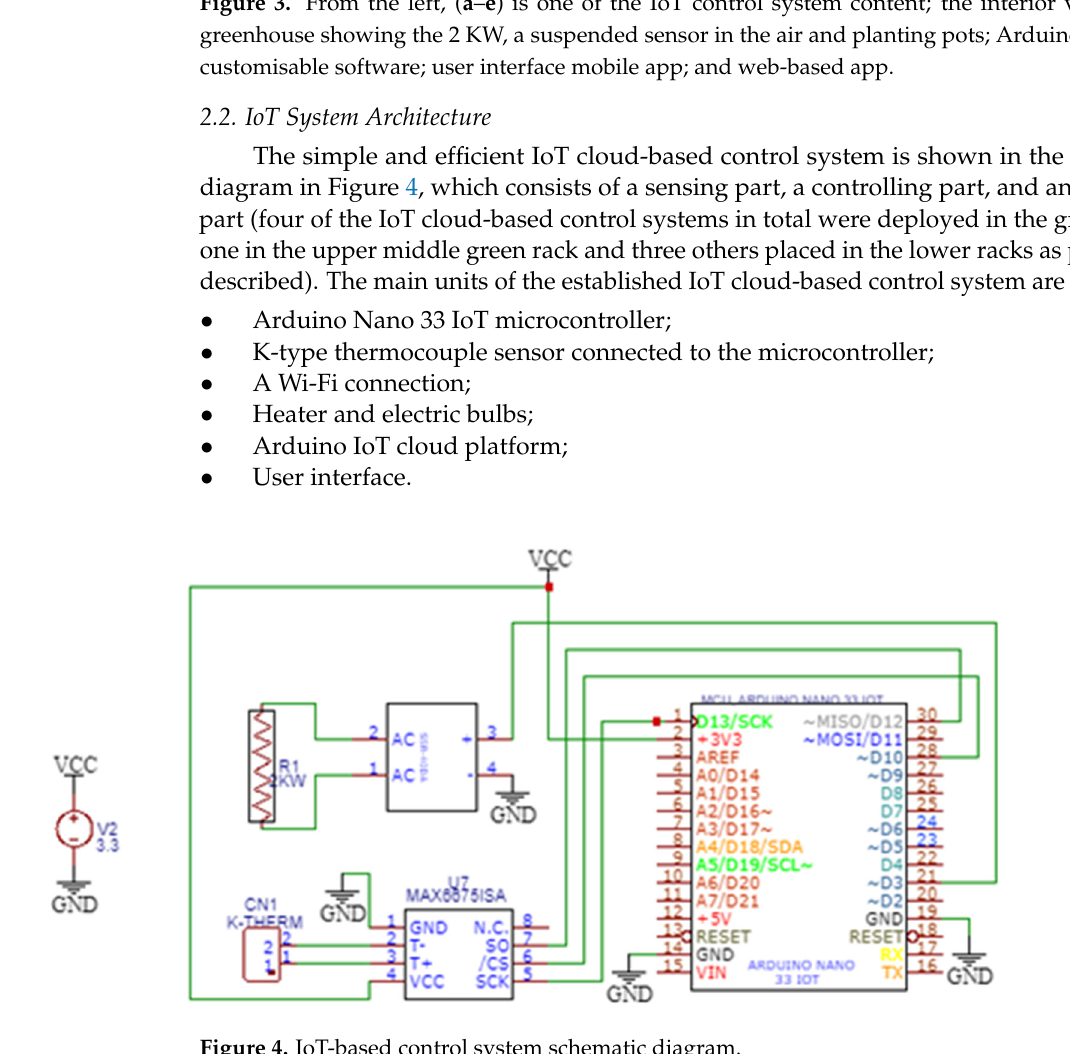
Figure 4. IoT-based control system schematic diagram .